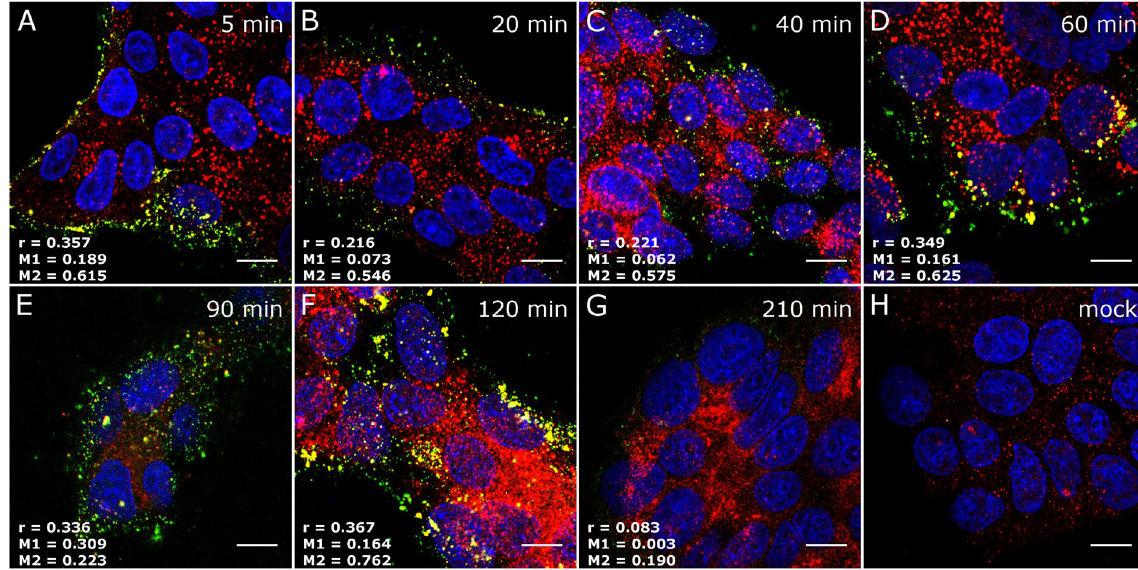
Figure 2. Co-localization of HCoV-OC43 with early endosomes’ marker EEA1. Co-localization of EEA1 with HCoV-OC43 in HCT-8 cells at different time points post infection was studied with confocal microscopy. Respective time points are indicated in the upper right corners. ( A ) HCoV-OC43-infected cells fixed 5 min p.i.; ( B ) 20 min p.i.; ( C ) 40 min p.i.; ( D ) 60 min p.i.; ( E ) 90 min p.i.; ( F ) 120 min p.i.; ( G ) 210 min p.i.; ( H ) mock- infected cells, stained with isotype control antibodies. The virus is visualized in green, EEA1 is shown in red, and nuclei are presented in blue. Scale bar = 10 μ m. Co-localization parameters: r – Pearson’s coefficient; M1 - Manders’ coefficient M1 (EEA1 overlapping with the virus); M2 - Manders’ coefficient M2 (the virus overlapping with EEA1). The experiment was conducted at least thrice and representative images are presented.